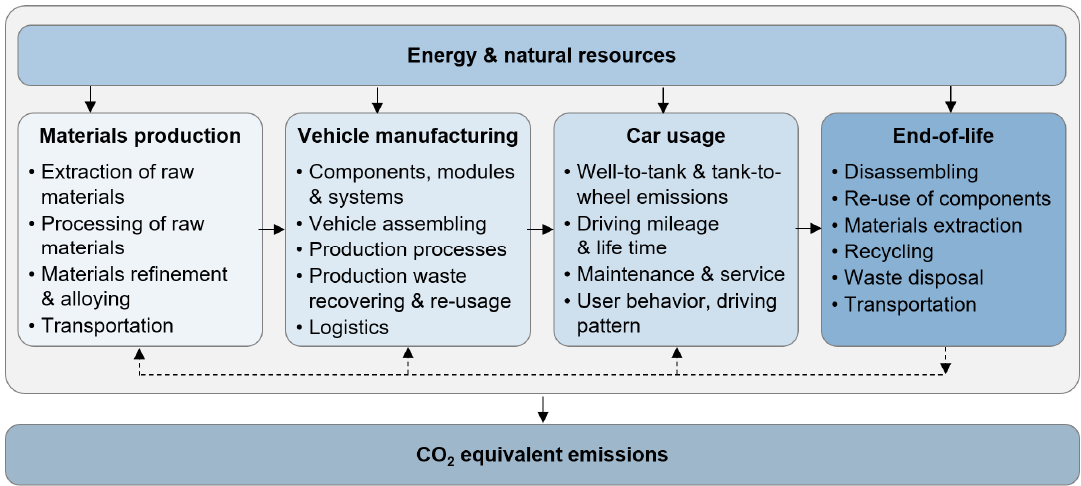
Figure 2. Main phases and influencing factors of a CO 2 equivalent-emissions-focused automotive LCA.